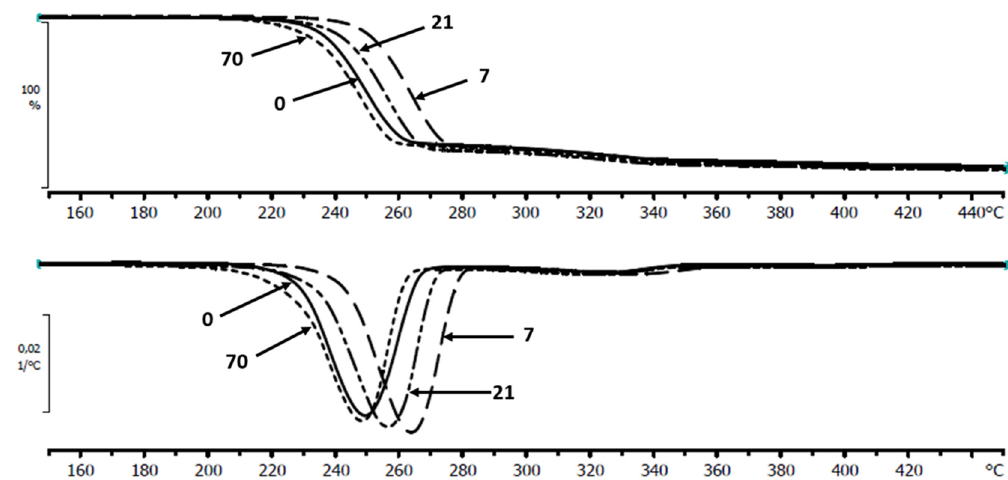
Figure 3. Selected TG and DTG thermograms of the P(3HB- co -4HB)/20WF composite before and after specific time (days) of incubation in buffer.